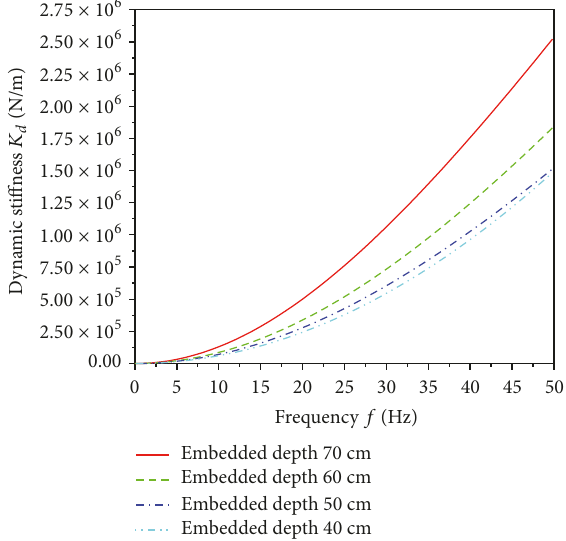
Figure 4: Amplitude frequency curve of dynamic stiffness at low frequency of centre of the